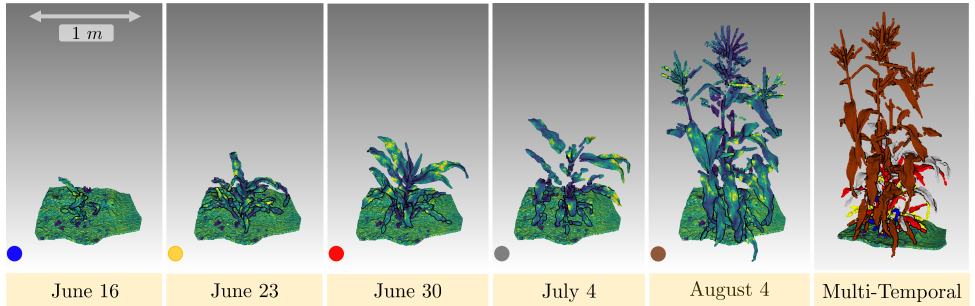
Figure 7. Single maize plant extracted from the point clouds at five days assisted by high-accurate georeferencing colored by laser intensity for 16 June to 4 August. The colorization, right, corresponds to the point cloud indices of the different days.